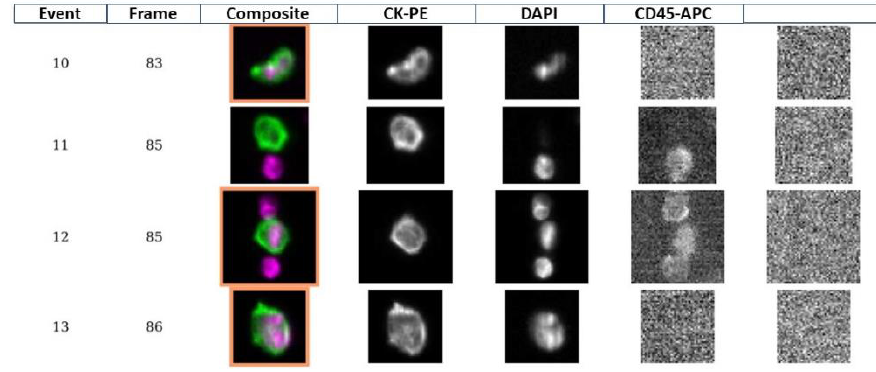
Figure 1. A gallery of images screened for CTCs.